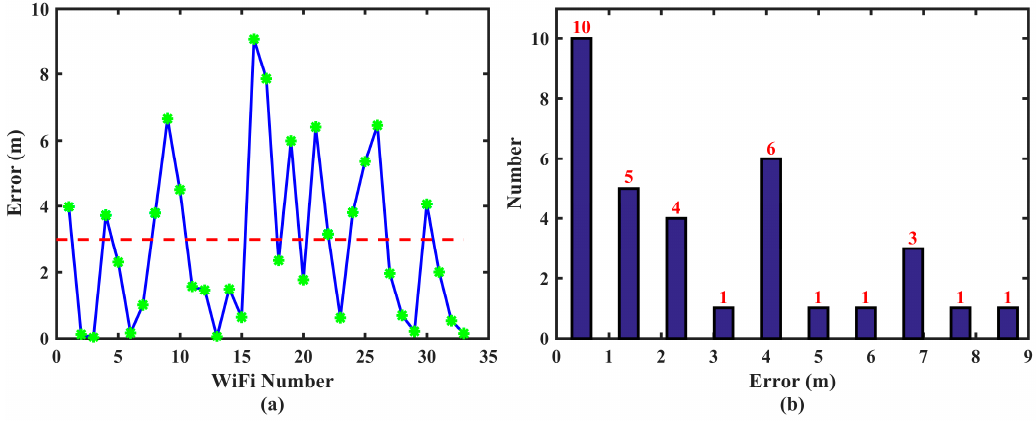
Figure 3. WiFi results in the walking state. ( a ) The error of WiFi; ( b ) The error histogram of WiFi.